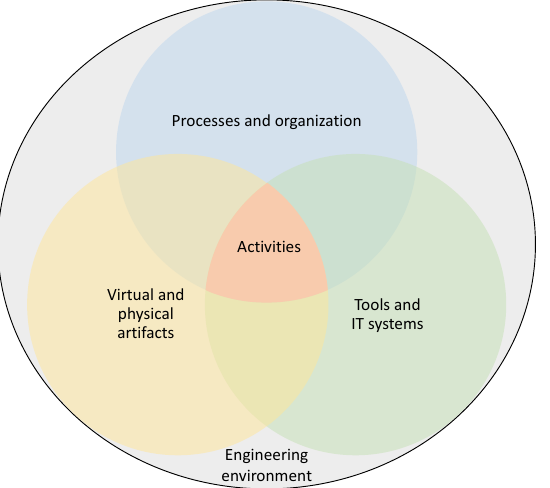
Figure 3. Engineering operating system, adapted from ([33] p. 319) with permission from